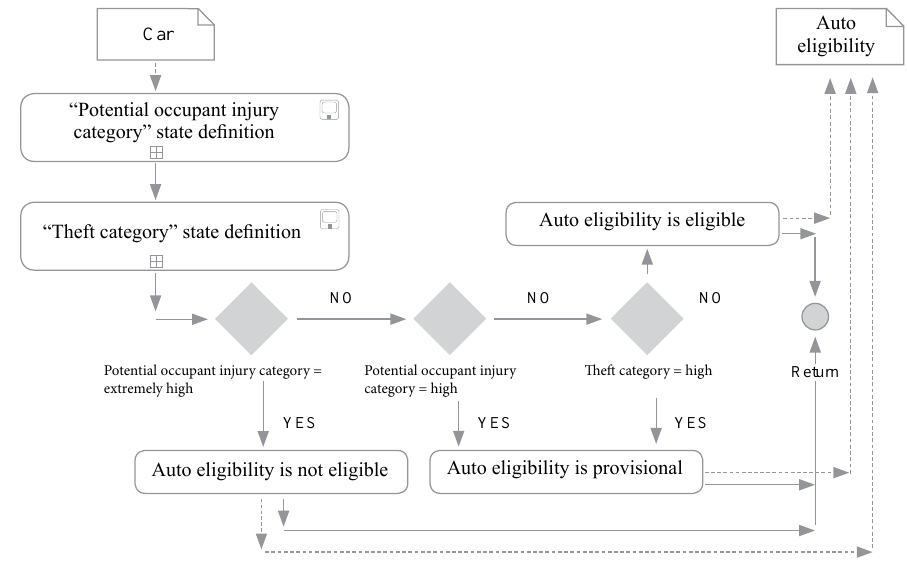
fig. 2. Business process of definition of automobile